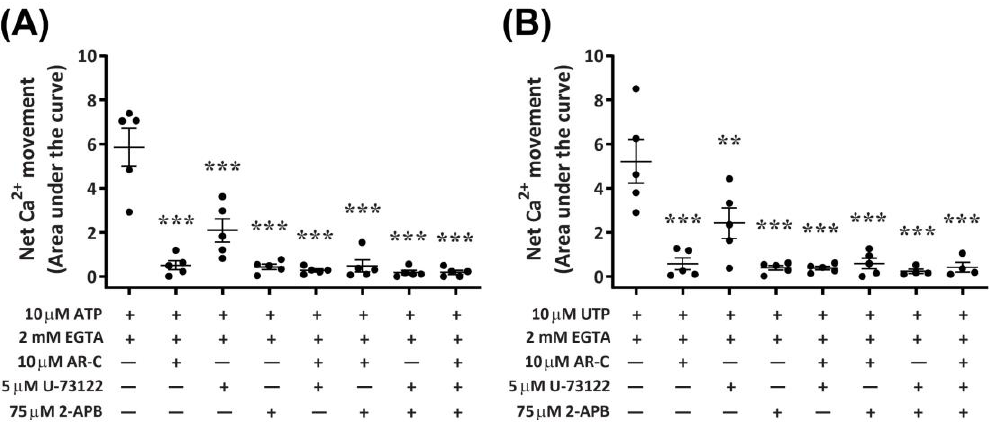
Figure 10. Nucleotide-induced Ca 2 + mobilization in DH82 cells depleted of extracellular Ca 2 + in the absence or presence of AR-C118925, U-73122 and 2-APB. DH82 cells were loaded with Fura-2 and preincubated in Ca 2 + -free solution containing 2 mM EGTA in the absence or presence of 10 µ M AR-C118925 (AR-C; 0.03% DMSO), 5 µ M U-73122 (0.05% DMSO) or 75 µ M 2-APB (0.15% DMSO) for 5 min. Cells were then exposed to ( A ) 10 µ M ATP or ( B ) 10 µ M UTP and Fura-2 fluorescence was recorded. Data shown are the mean ± SEM from five independent experiments. ** p < 0.01 and *** p < 0.001 compared to respective nucleotide alone, analysed using a one-way ANOVA with Bonferroni post hoc test.